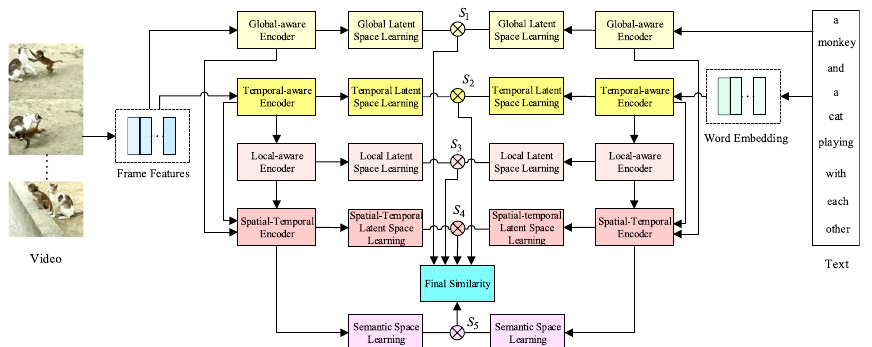
Fig. 2 The framework of our proposed LADN method. LADN first utilizes multi-level encoders to extract global, temporal, local, and spatial–temporal information in videos and text. Then, they are mapped into four different latent spaces and a semantic space. Finally, LADN aligns different levels of information in various